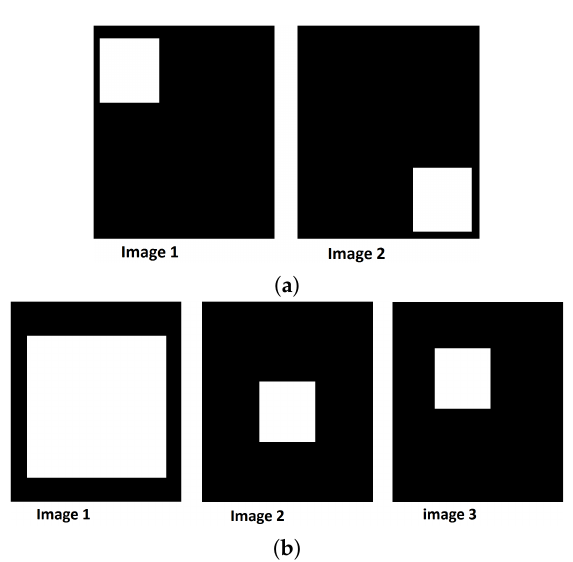
Figure 9. ( a ) Example of a pair of binary images for pattern spectrum correlation discussion; ( b ) Example of triplet of binary images for distance function correlation